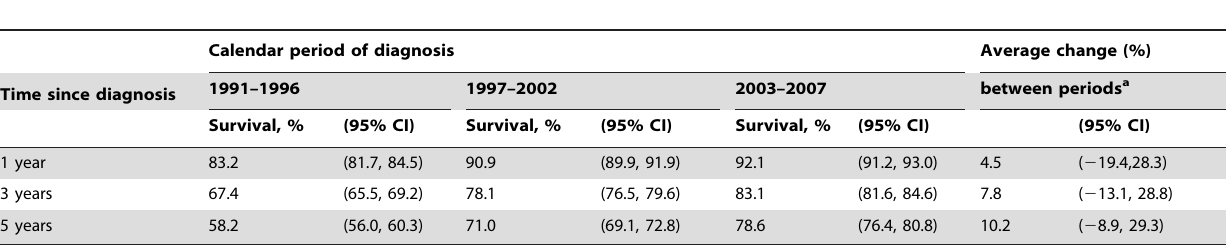
Table 2. Trends in relative survival (%) of prostate cancer patients by period of diagnosis in the West of Scotland: 1991 to 2007.